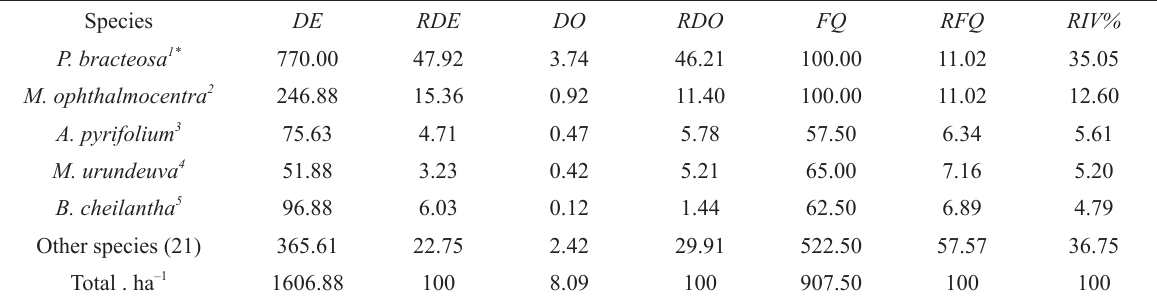
Phytosociological parameters of the five tree species of highest importance value ( HIV ).